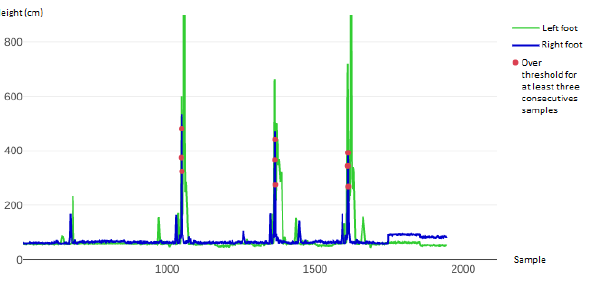
Figure 12. The green and blue lines relate to the left and right foot, respectively. The red dots highlight when both feet surpassed the threshold, with three red dots indicating that a valid jump was detected. This chart shows three successful detections of three technical elements (double